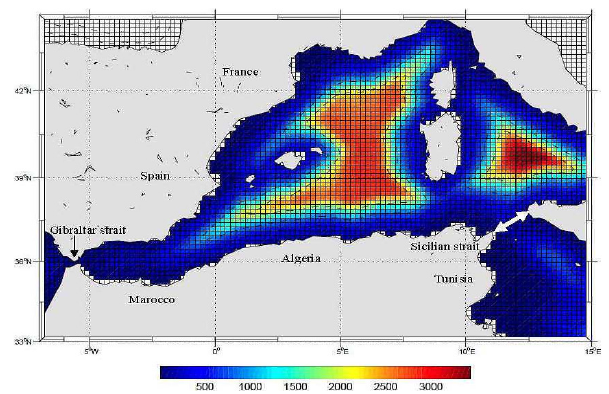
Fig. 1. The model domain and its bathymetry Figure 1: The model domain and its bathymetry (m)